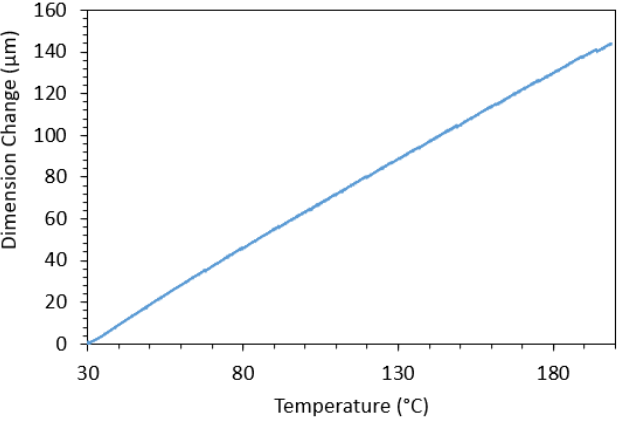
Figure 10. Thermal expansion of CS25 silicone rubber, dimension change vs. temperature.